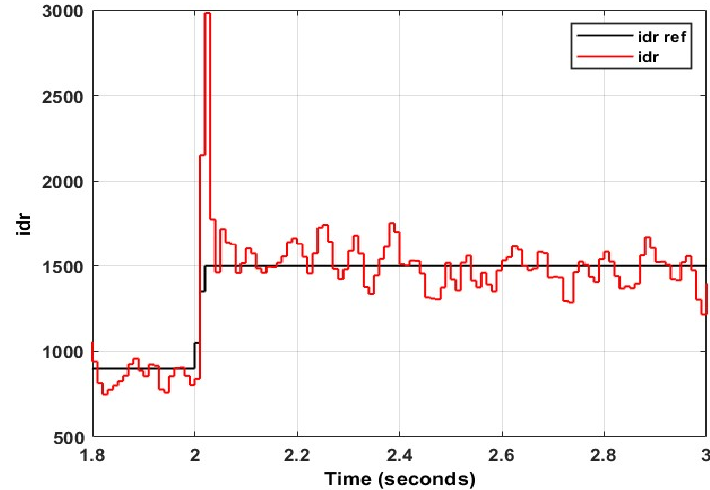
Figure 35. Rotor direct axis current ripple using PI at 80% dip.